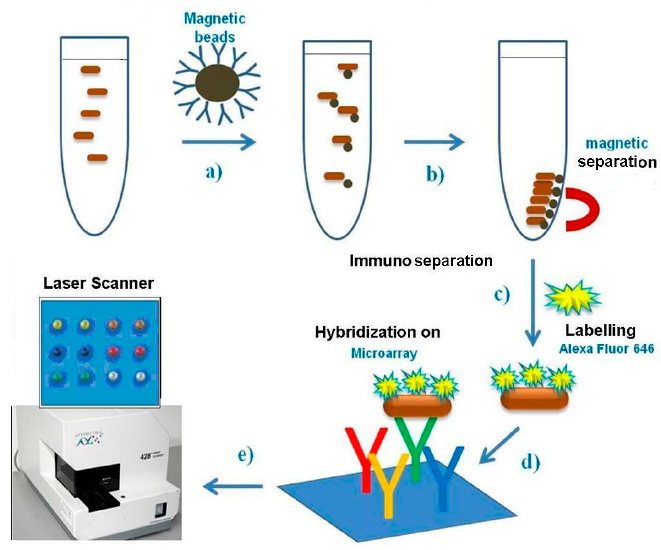
Figure 1. Scheme of protocol used, from Pathatrix immunoseparation to protein chip detection.